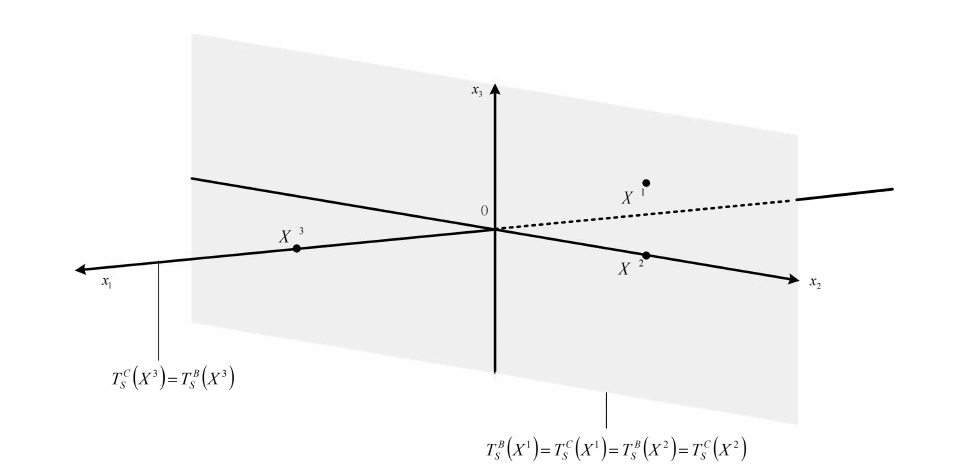
Figure 1. Bouligand tangent cones and Clarke tangent cones of S in R 3 , where S = { x ∈ R 3 : (cid:107) x (cid:107) ≤ 1 } , x 1 = ( 0,1,1 ) , x 2 = ( 0,1,0 ) and x 3 = ( 1,0,0 ) 2,0